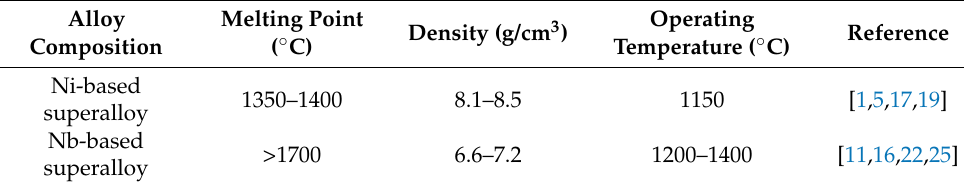
Table 1. Comparison of properties of Ni base superalloy and Nb base